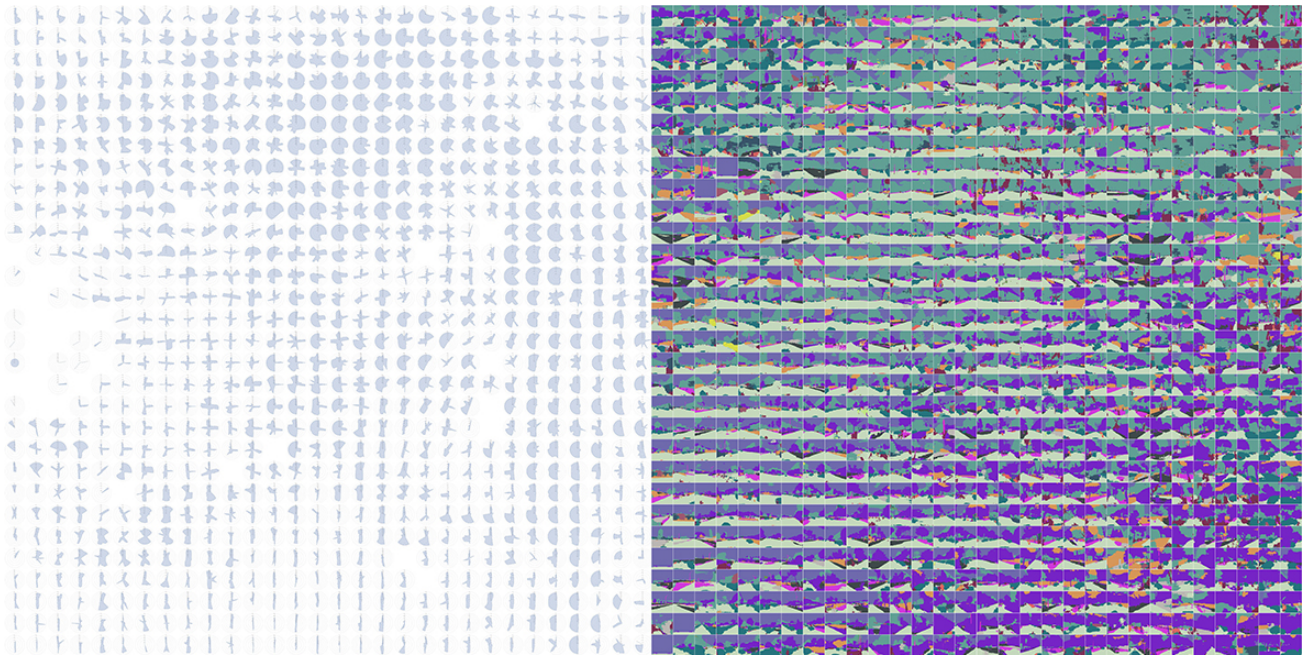
Figure 8. Results of ray SOM ( left ) and mask SOM ( right ) with a demonstration sample for each